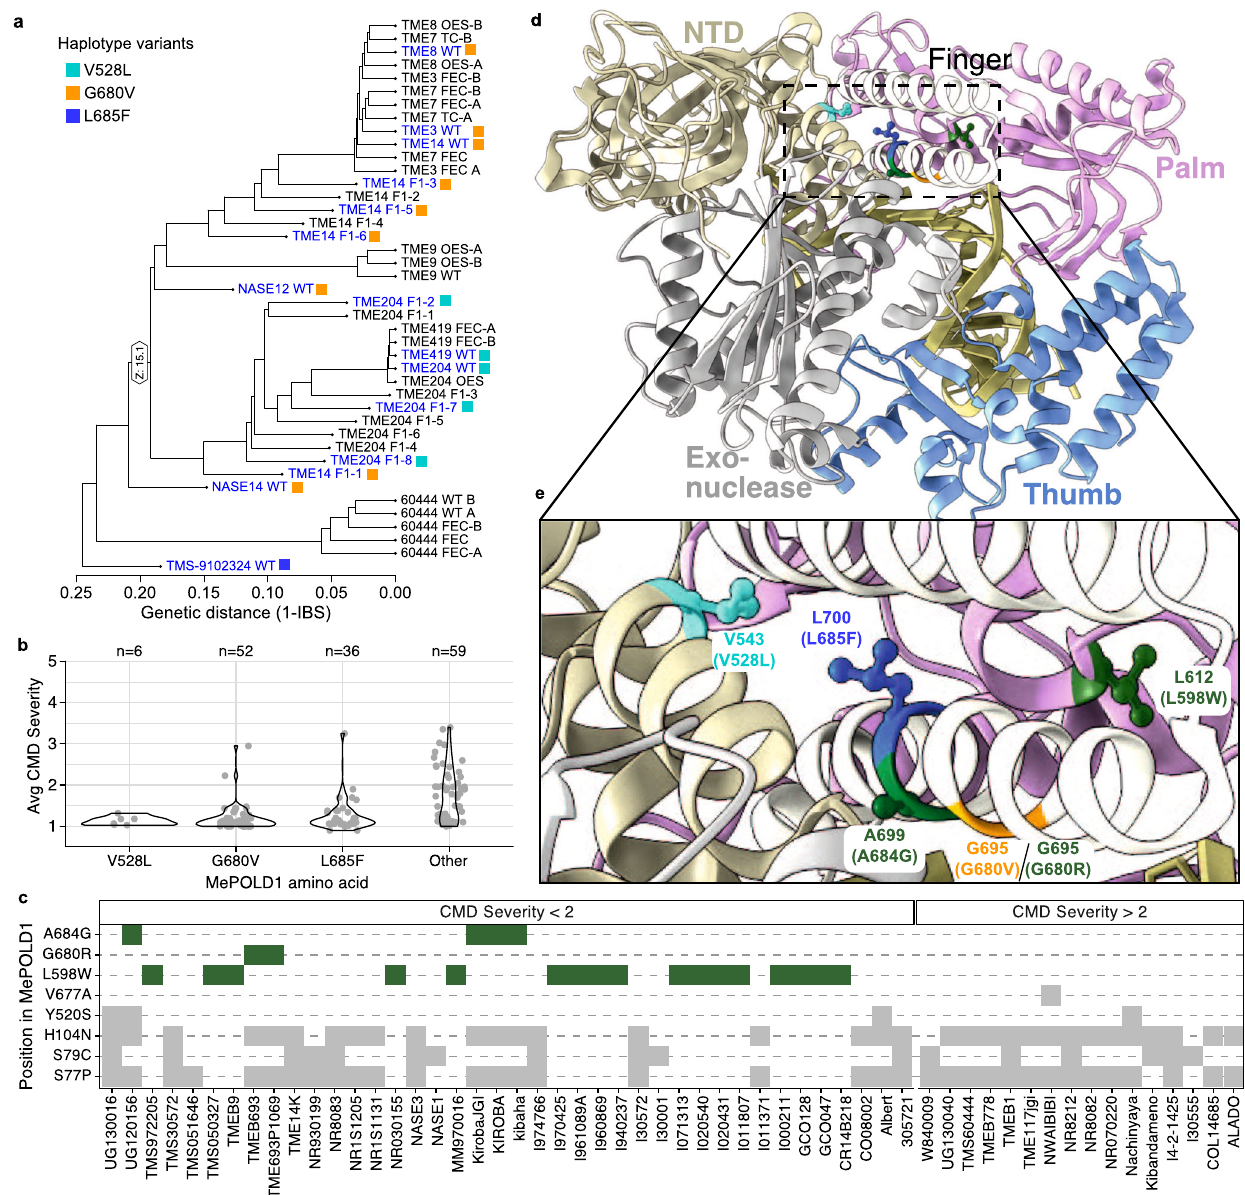
Fig. 4 Nonsynonymous SNPs in MePOLD1 . a Dendrogram of Manihot esculenta cultivars analysed by whole genome sequencing. Nonsynonymous SNPs (nsSNPs) in MePOLD1 of various cultivars segregate with CMD2 resistance. Names of resistant cultivars are in blue and harbour either the V528L (cyan), G680V (orange), or L685F (blue) mutation. b Average CMD severity across a diverse set of cassava cultivars from the HapMapII population 37 that have either one of the three mutations from ( a ) or an unknown nsSNP in MePOLD1 ("Other ” ). c Identity of all nsSNPs in MePOLD1 of varieties from the “ Other ” category in ( b ). Varieties are split by CMD severity score, where less than 2 and above 2 are resistant and susceptible, respectively. In green are the nsSNPs found only in cultivars with CMD severity scores below 2; all other nsSNPs are in grey. d Three-dimensional structure of S. cerevisiae POLD1 (PDB: 3IAY) with corresponding MePOLD1 mutations highlighted; V528L in cyan, G680V in orange, and L685F in blue. Additional residues identi fi ed in ( c ), L685F and L598W, are in green. Residue name and position in ScPOLD1 are noted and the corresponding information for MePOLD1 is in parentheses. POLD1 functional domains, N-terminal (beige), exonuclease (grey), and structural motifs of the polymerase domain, palm (pink), fi ngers (white), and thumb (blue), are highlighted. e Zoomed in view of the 3D structure centred on the mutated residues found in